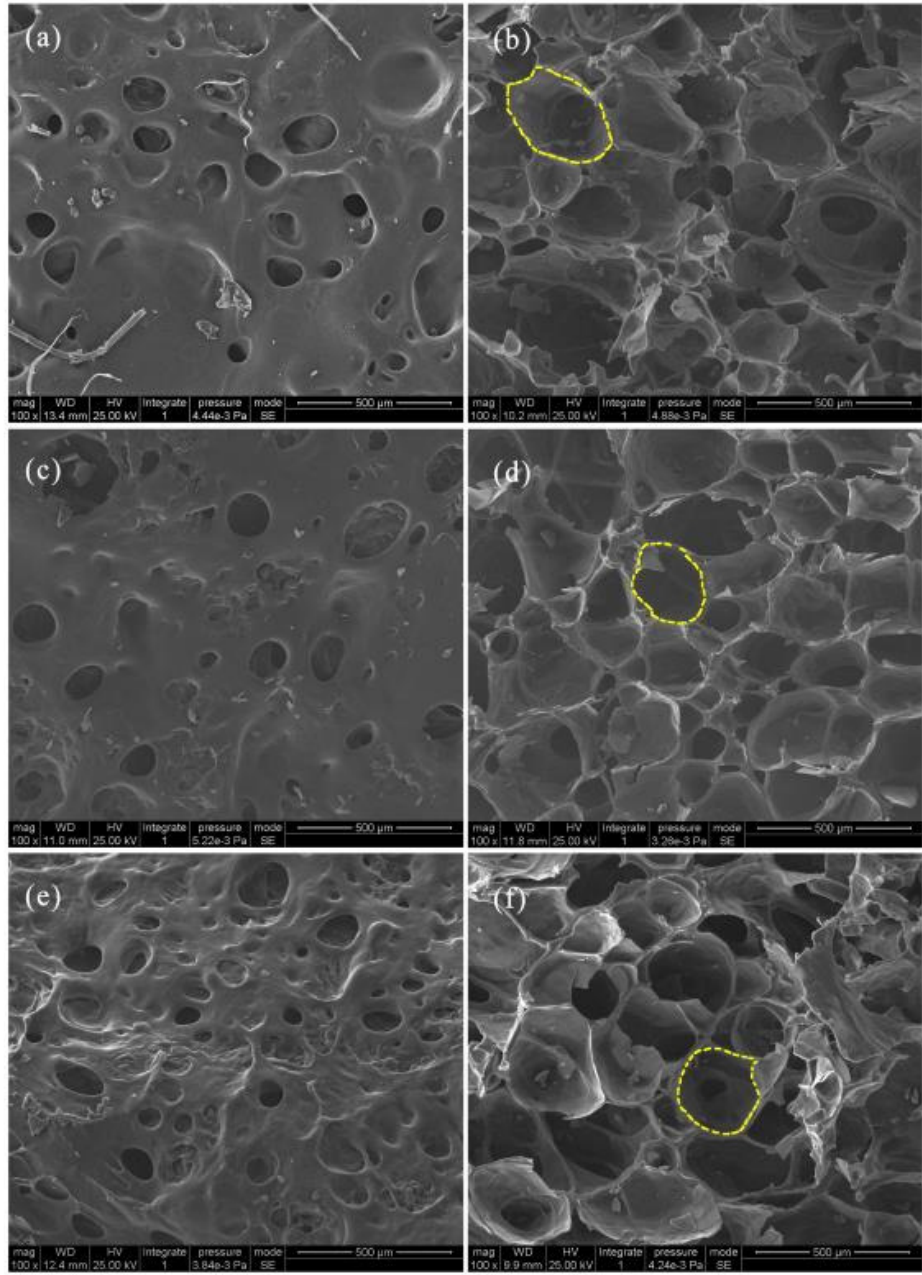
Figure 3. The surface morphologies of foams made from low ( a ), medium ( c ), and high ( e ) viscosity CTS and the corresponding inner morphologies ( b , d , f ). Scale bar = 500 μ m